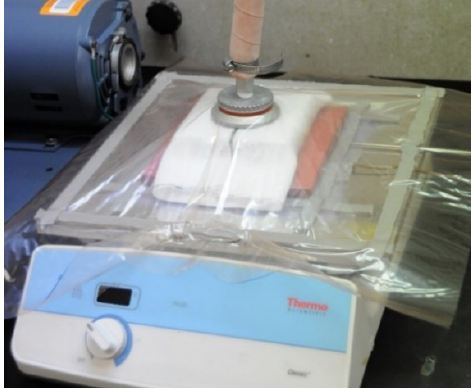
Figure 8. Photograph of the vacuum bagging mold assembly.